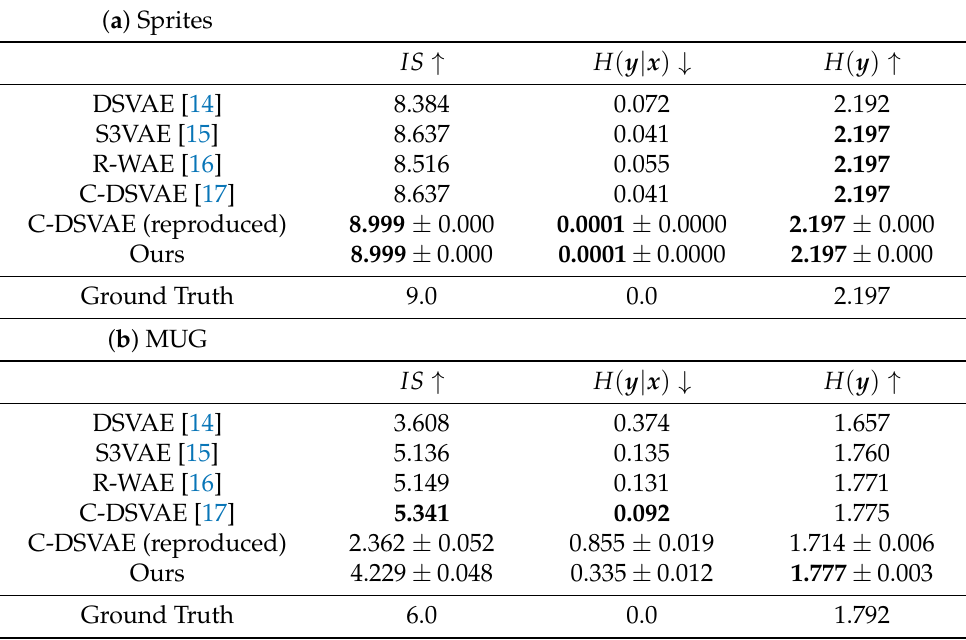
Table 6. Entropy-based metrics for the fixed dynamic latent variable and randomly sampled static latent variable. For C-DSVAE (reproduced) and our method, the average classification accuracies over ten runs are presented; the others are taken from the literature [14–17]. In the tables, the upward (downward) arrows ↑ ( ↓ ) indicate that the higher (lower) the values, the